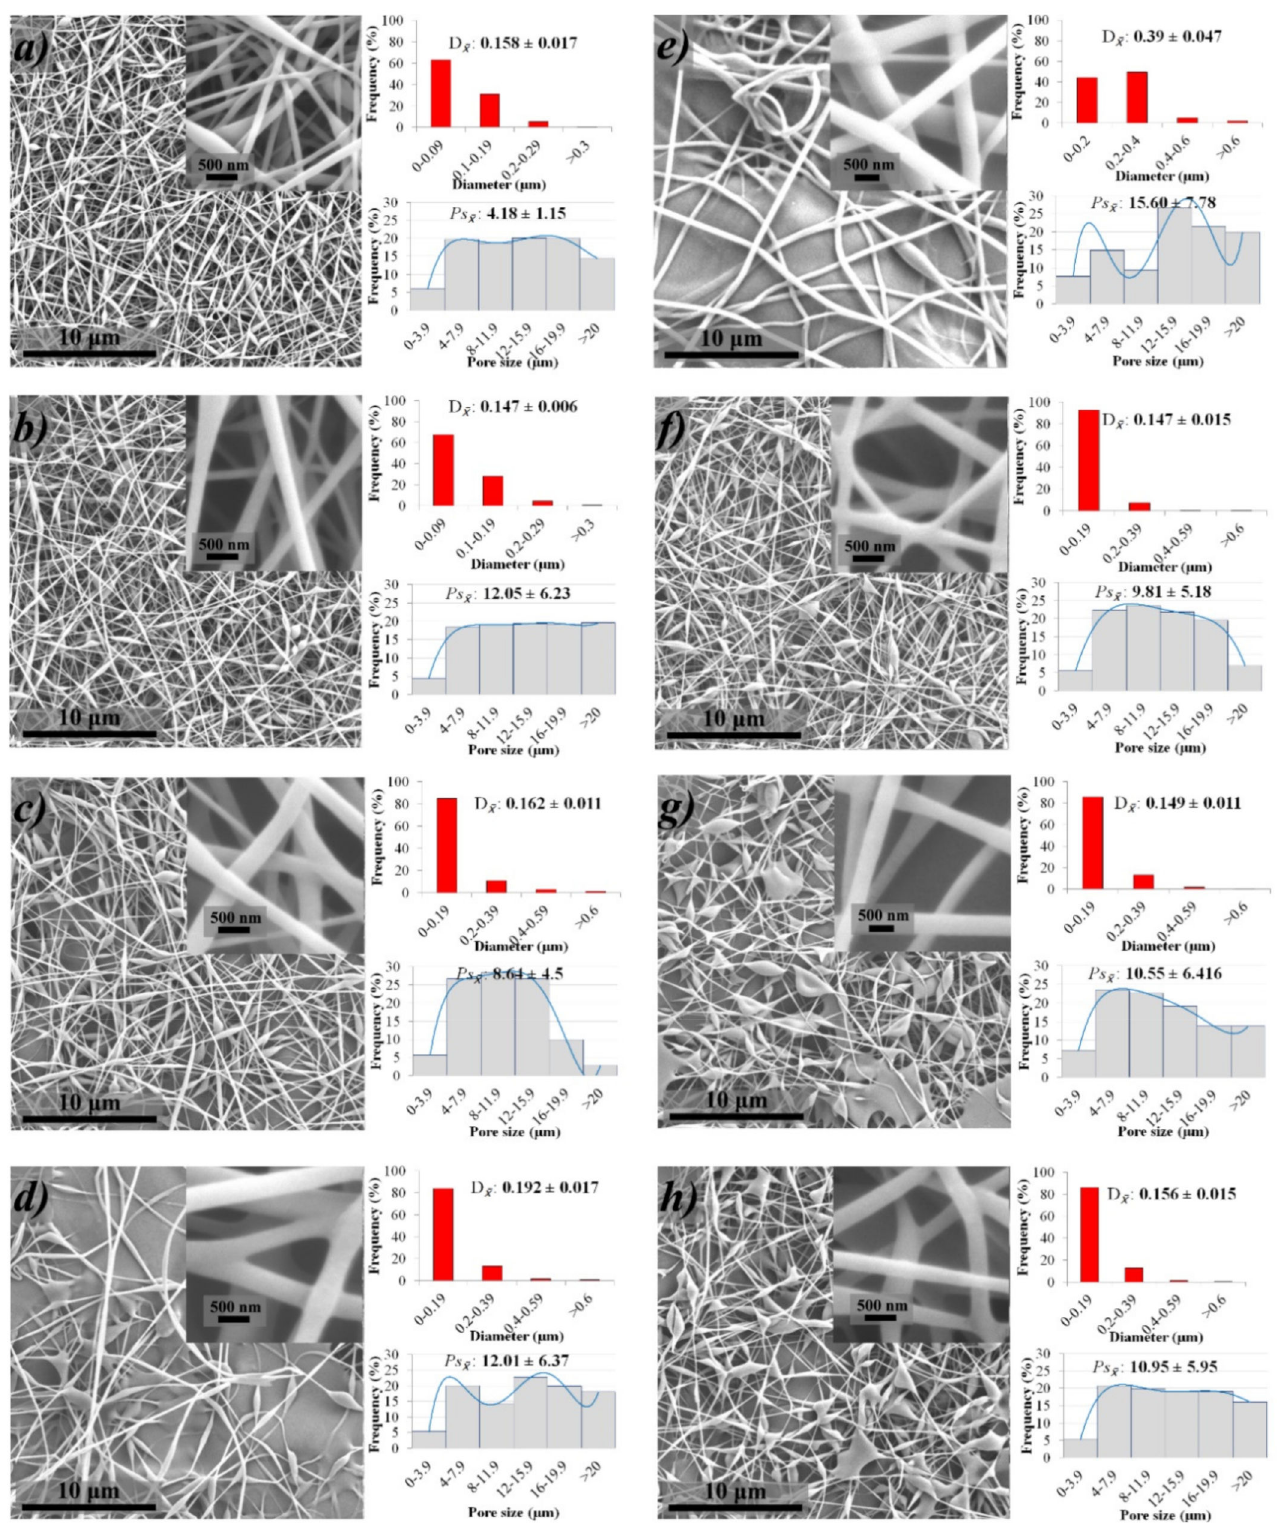
Figure 3. Morphological characterization by SEM of fibers (inserted SEM images at 30000 × ) and biomembranes (SEM images at 2000 × fabricated by electrospinning technique from PVA/HC/EEHP: ( a ) 6-0-0, ( b ) 6-0-8, ( c ) 6-0-16, ( d ) 6-0-32, ( e ) 6-5-0, ( f ) 6-5-8, ( g ) 6-5-16, and ( h ) 6-5-32. Fiber diameter (mean: D x ( µ m) and distribution histogram (red)) and pore size (mean: Ps x ( µ m), and distribution histogram (grey)). Nomenclature: % PVA (6)-% hydrolyzed collagen (0, 5)-% EEHP (0, 8, 16,